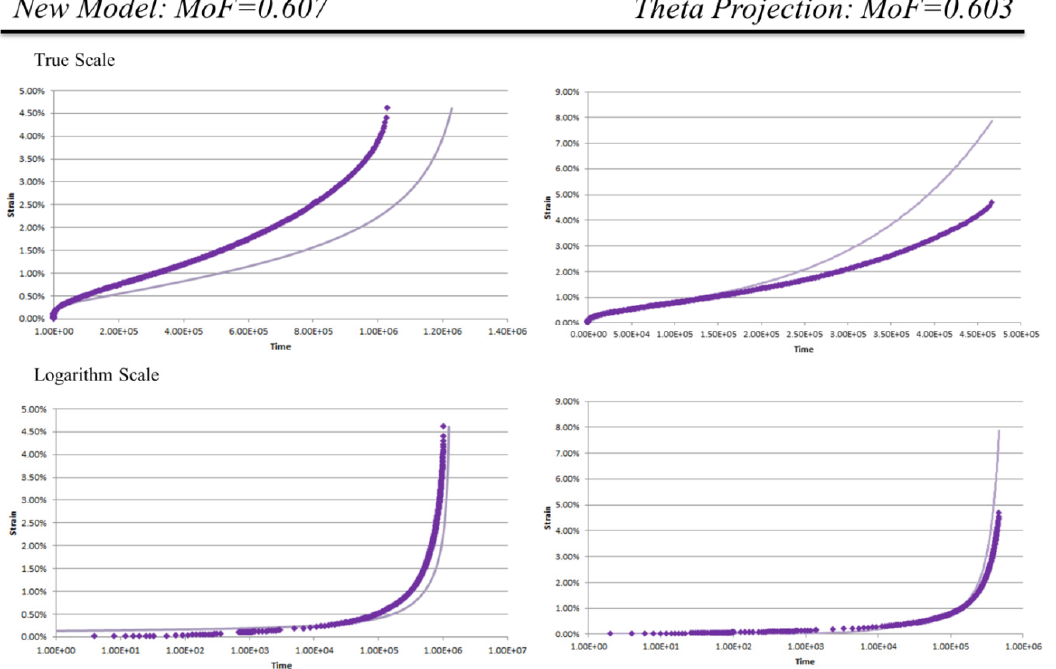
Figure 4. Comparison of New Model and Theta Projection for MoF ≈ 0.6. Experimental data ( ♦ ) model prediction ( ▬ ).